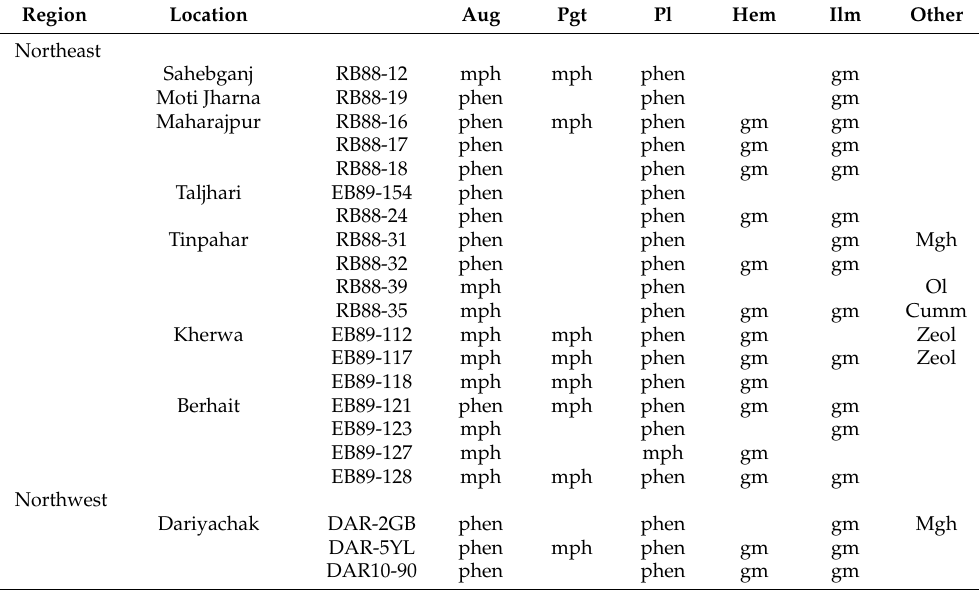
Table 1. Mineral assemblages in the Rajmahal